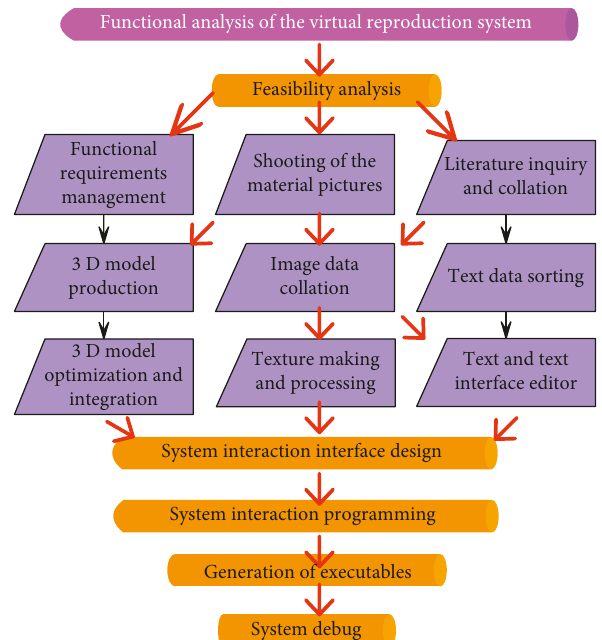
Figure 7: Development flow chart.